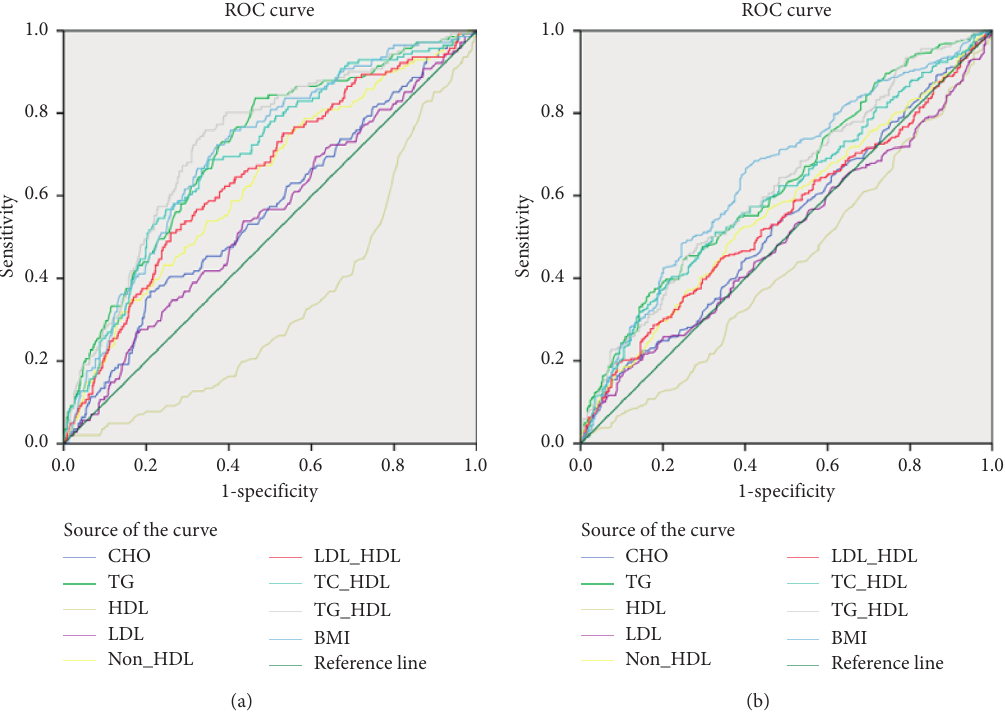
Figure 1: ROC curves of TG/HDL-C and other lipid components or markers of insulin resistance. ROC curves of TC, TG, HDL-C, LDL-C, non-HDL-C, LDL-C/HDL-C, TC/HDL-C, TG/HDL-C, and BMI were presented in nonobese and obese subjects. (a) ROC curves in nonobese subjects. (b) ROC curves in obese